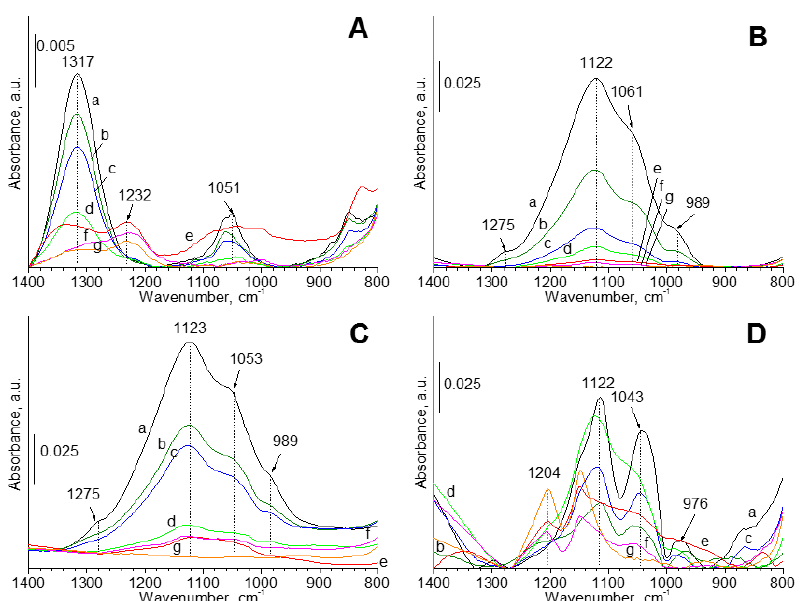
Figure 7. Attenuated Total Reflectance-Fourier Transform Infrared (ATR-FTIR) spectra recorded for oxides: ( A ) before and ( B ) after adsorption of H 2 S on the surface; ( C ) after adsorption of H 2 S on the surface and the heating the supports with sulfur at 373 K for 24 h in air; ( D ) with sulfur species after their modification with gold species. The ATR-FTIR spectra were recorded for samples based on the supports: (a) CeO 2 , (b) Ce x Zr y O z (4:1), (c) Ce x Zr y O z (2:1), (d) Ce x Zr y O z (1:1), (e) Ce x Zr y O z (1:2), (f) Ce x Zr y O z (1:4), and (g) ZrO 2 .